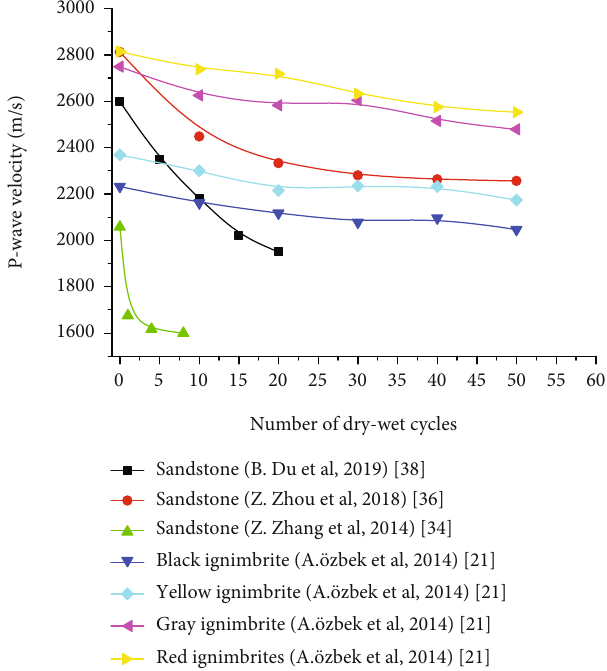
Figure 6: Variation of P-wave velocity after di ff erent dry-wet cycles.